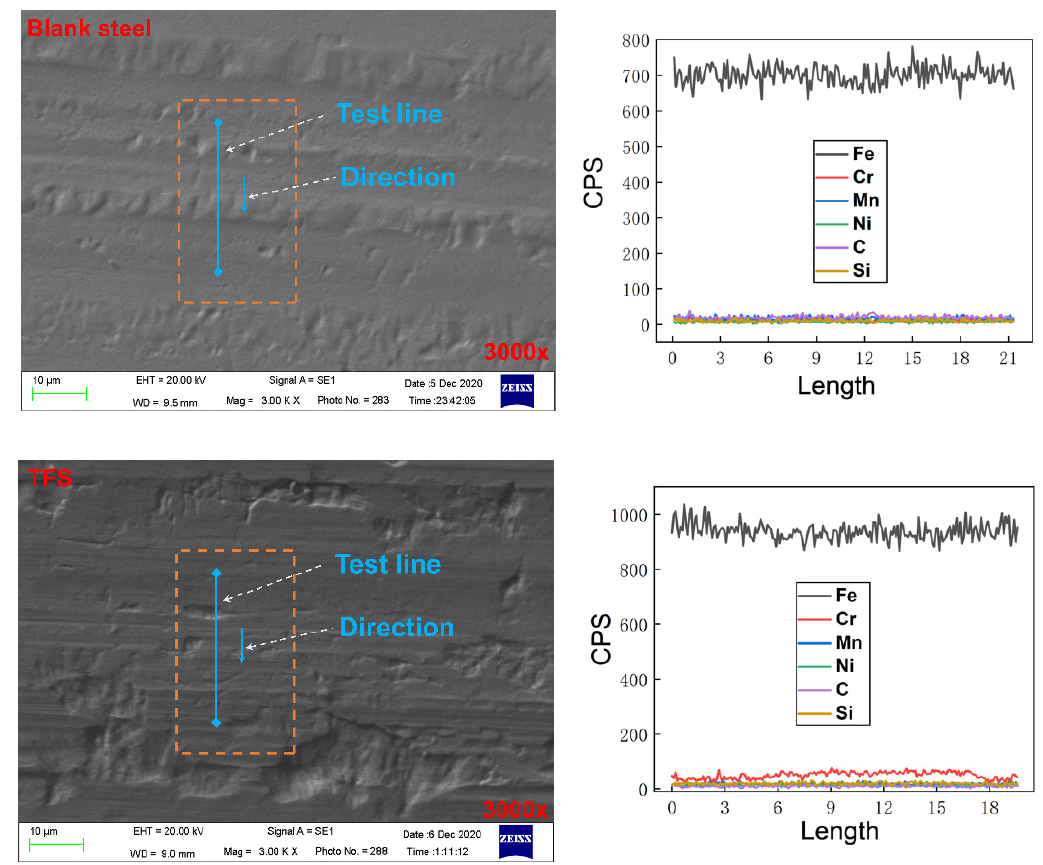
Figure 7. The SEM images and EDS curve of the blank steel and